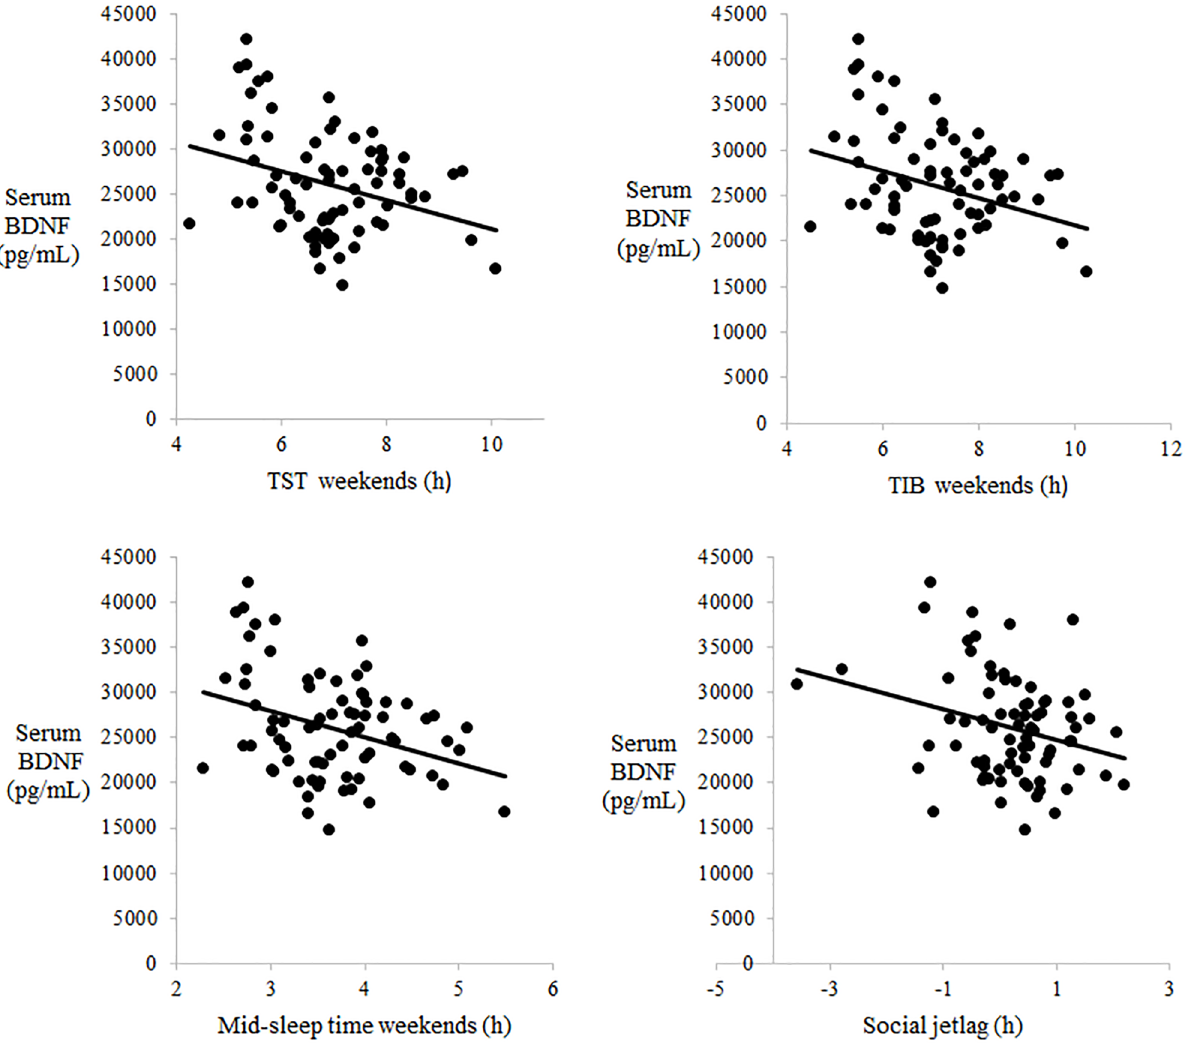
Fig 1. Correlations between serum BDNF levels and the sleep pattern on weekends. Analyses showed significant correlations between serum BDNF levels and the sleep pattern: TST on weekends (r = − 0.32, p < 0.01), TIB on weekends (r = − 0.30, p < 0.01), MS on weekends (r = − 0.33, p < 0.01), and social jetlag (r = − 0.28, p <